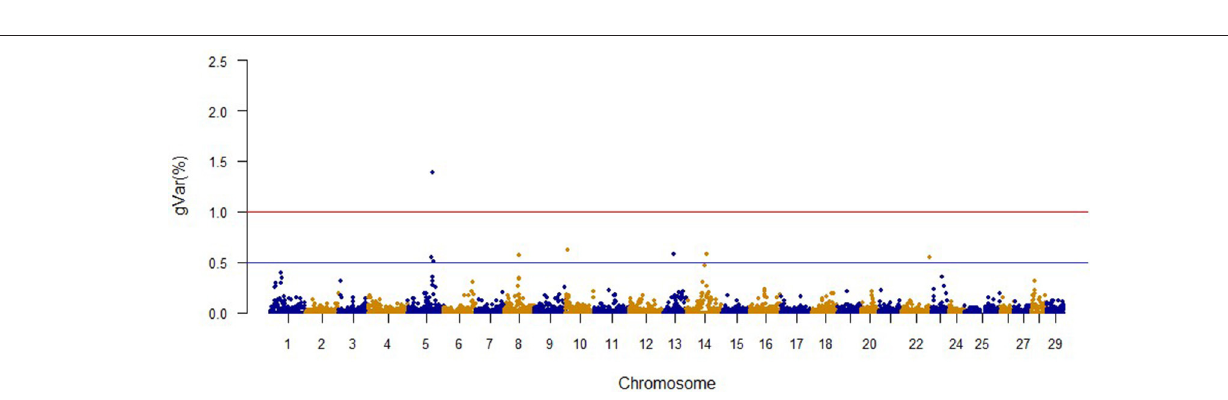
FIGURE 3 | The proportion of genetic variance explained by 20-SNP regions for 10-month body